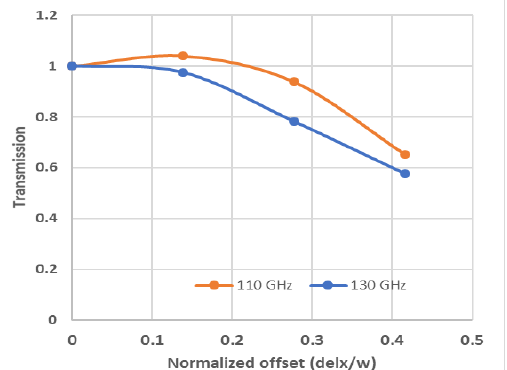
Figure 7: Transmission vs. normalized